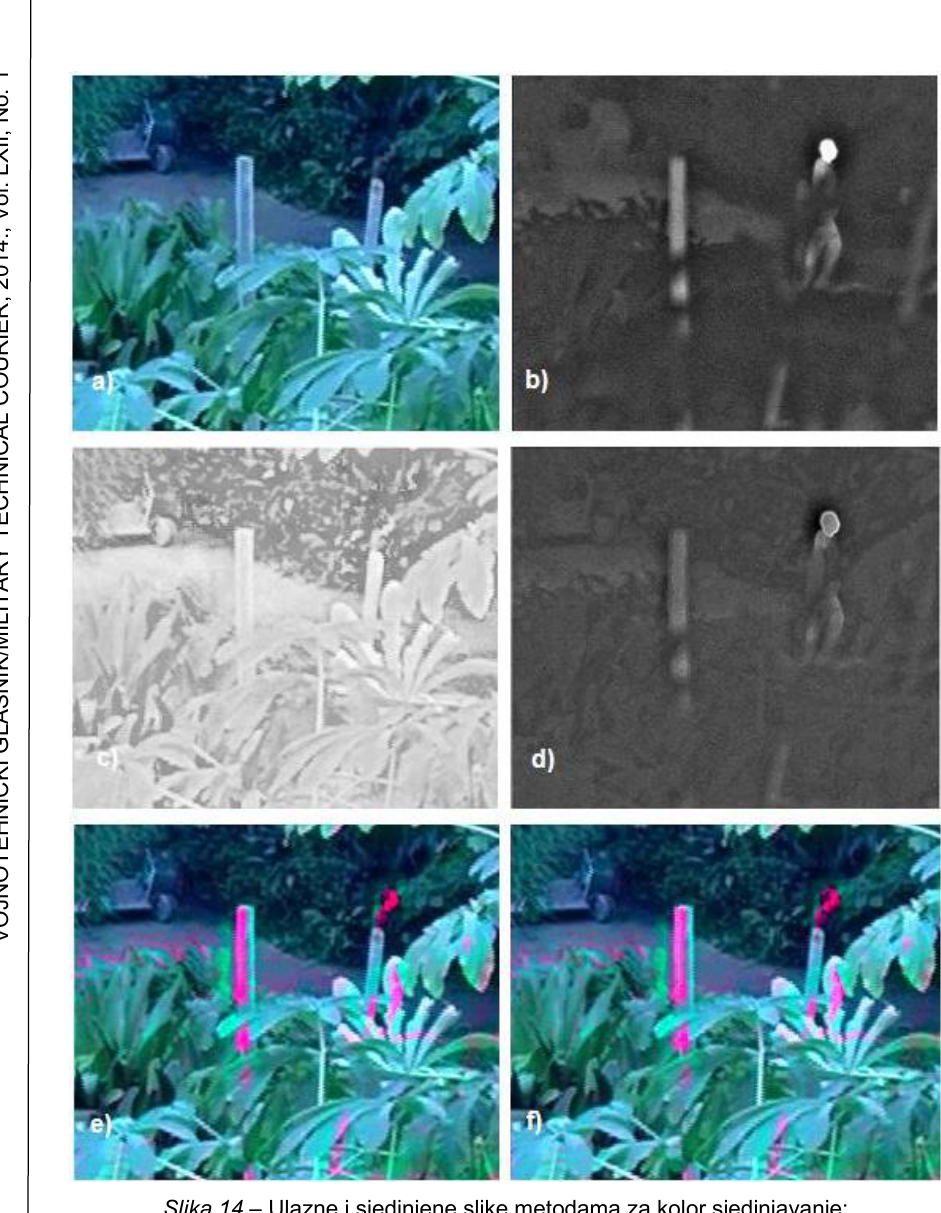
Figure 14 – Color fusion of the EDEN dataset: a) and b) true color and IR inputs, c) β chanal of color image, d) fused β chanal, e) and f) fusion with the proposed method without and with structure